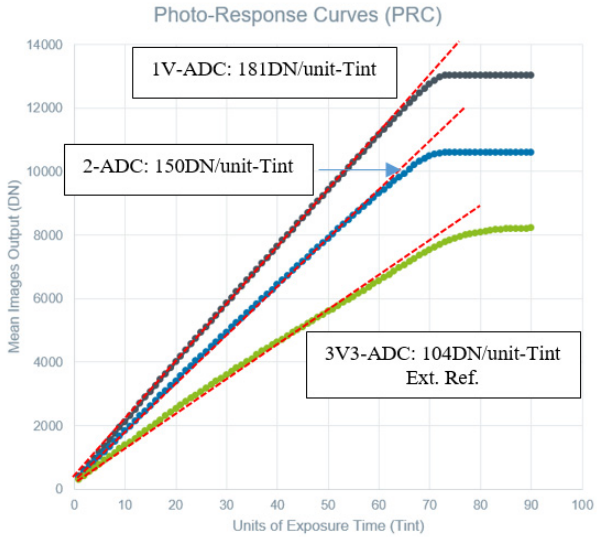
Figure 7. Combined photo response curve (PRC) data as a function of units of Tint (x19 us).